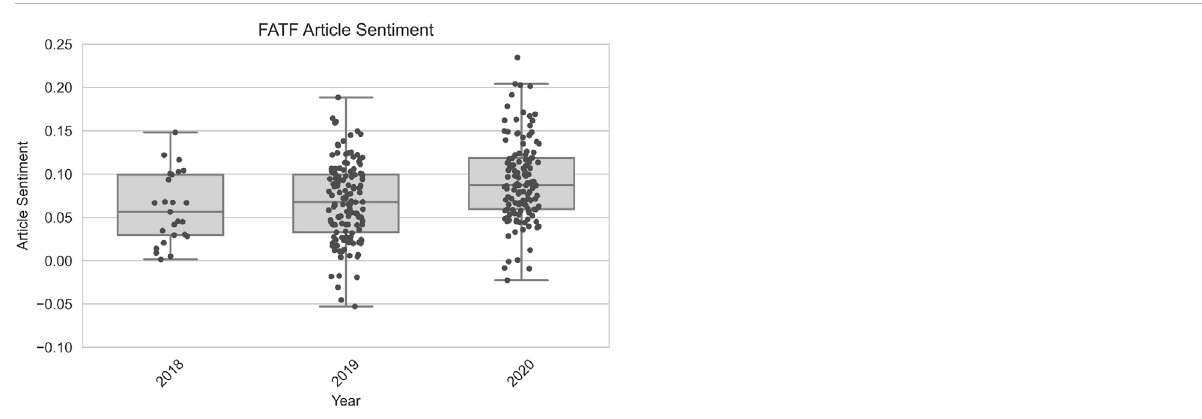
TABLE 3 | Industry reception of FATF